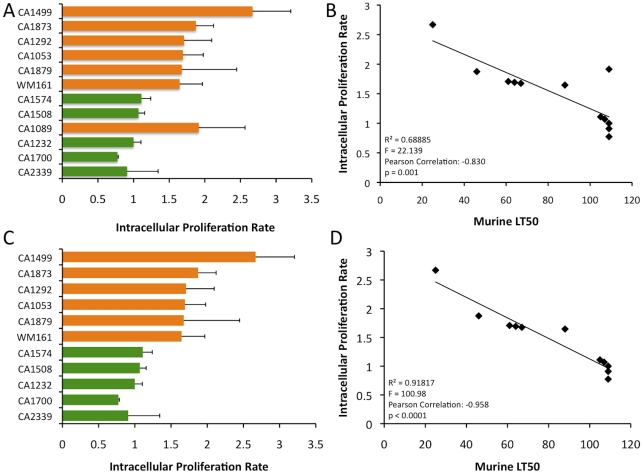
In vitro analysis of intracellular proliferation rates (IPR) show increased proliferation levels in VGIIIa and IPR values correlate with in vivo virulence.A) IPR values for the 12 isolates examined in mice; orange indicates VGIIIa and green indicates VGIIIb. B) Regression analysis illustrating a linear correlation of IPR and the time to 50% lethality in mice. C) IPR values for the isolates examined in mice, CA1089 excluded; orange indicates VGIIIa and green indicated VGIIIb. D) Regression analysis illustrating a linear correlation of IPR and the time to 50% lethality in mice with isolate CA1089 excluded.